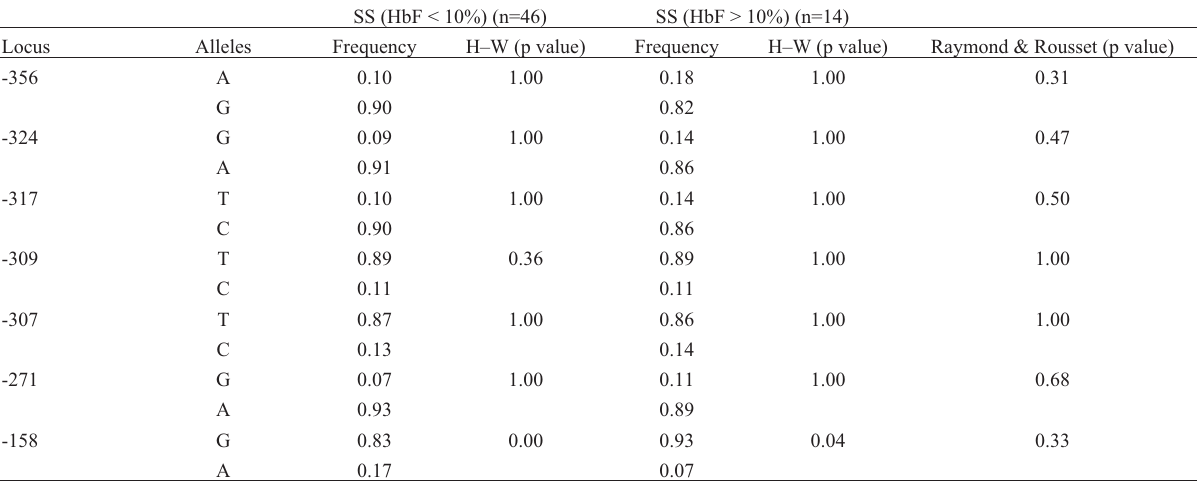
Table 1 - Allele frequency of the polymorphisms observed in the promoter region of the G-gamma globin gene in patients with sickle cell anemia. Col- umnH–W(pvalue)showsthep-valuefromtheHardy–Weinbergequilibriumtest.TheRaymond&Rousset(pvalue)columnshowsthep-valuefromthe test. Seven polymorphisms were identified. There are no significant differences in the allele frequency of these sites between patients with high and low HbF levels.